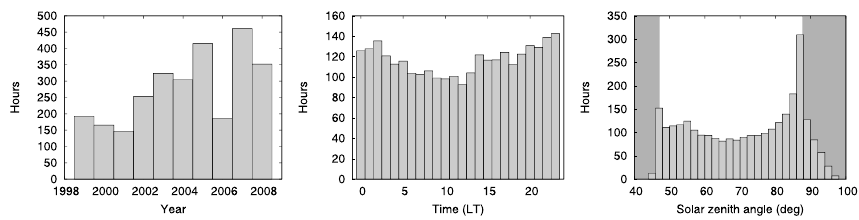
Fig. 1. Simultaneous measurement times of the ALWIN radar and RMR lidar in hours as a function of year, local time and solar zenith angle. Extreme solar zenith angle (shaded) are not discussed because they are not distributed equally throughout the season.